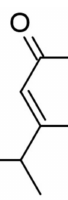
Figure 7. Chemical structure of